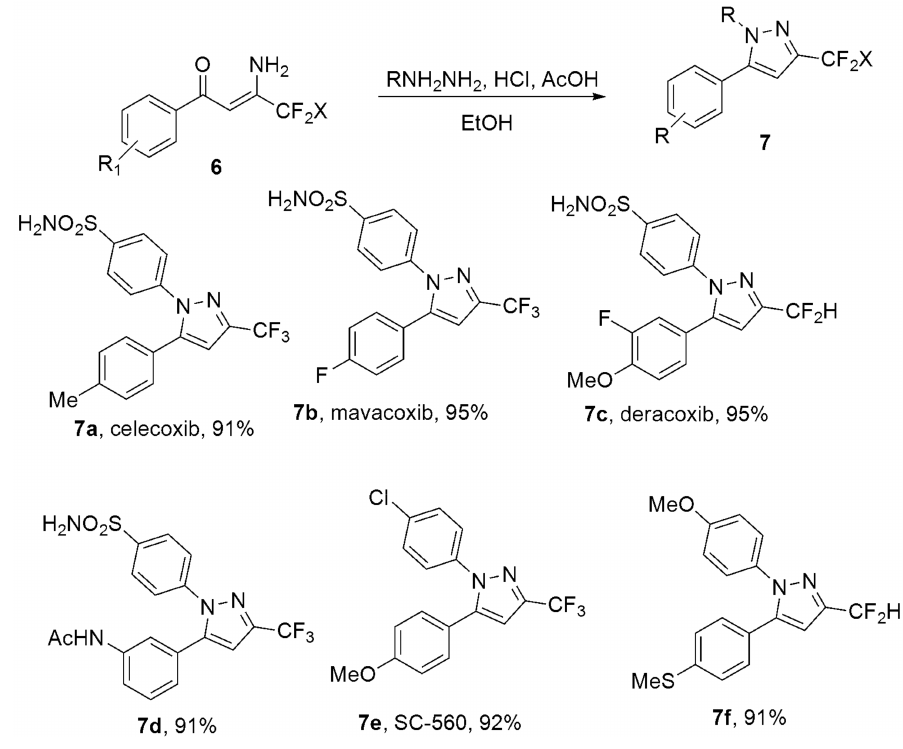
Scheme 2. Synthetic route to the formation of celecoxib, deracoxib, and mavacoxib using hy- drazine [7].